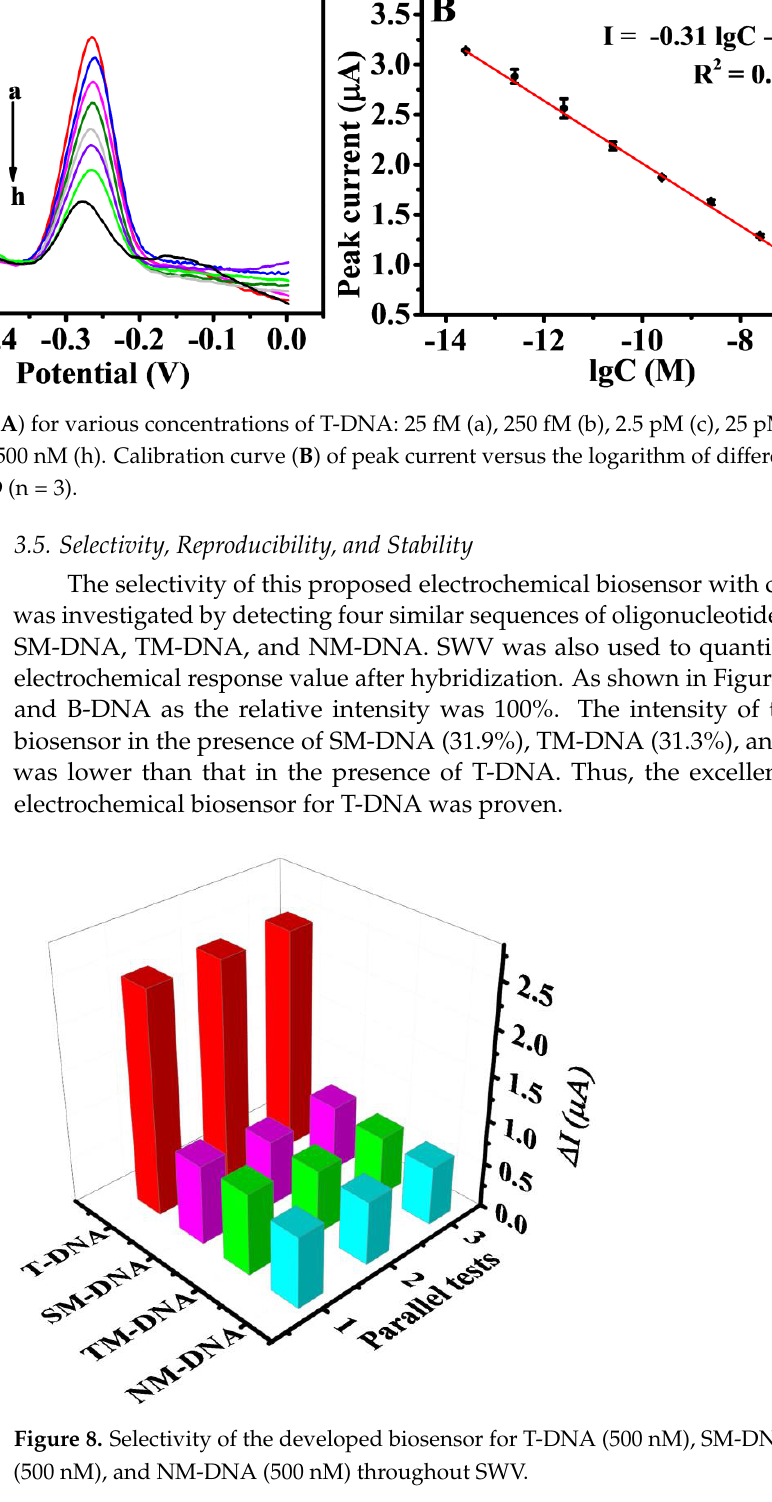
(500 nM), and NM-DNA (500 nM) throughout SWV.